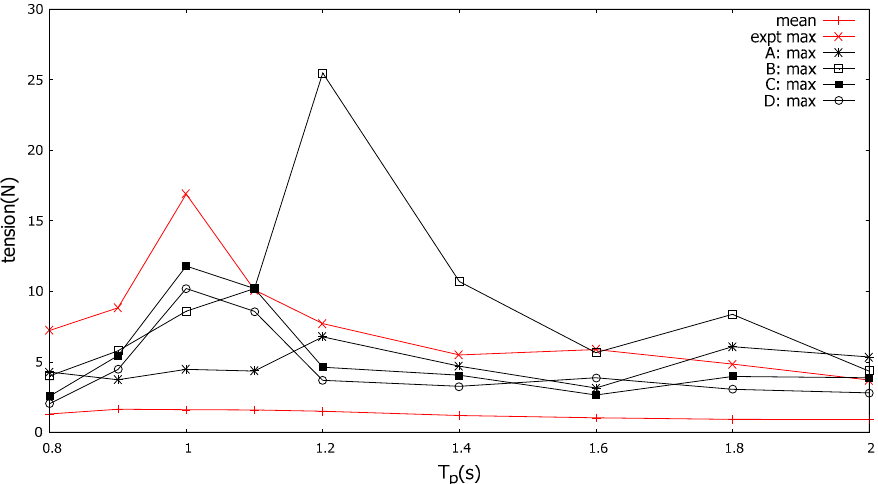
Figure 14. Variation of peak / maximum tension with T p for H s ≈ 0.04 m from linear di ff raction / radiation model with measured mean force and experiment.